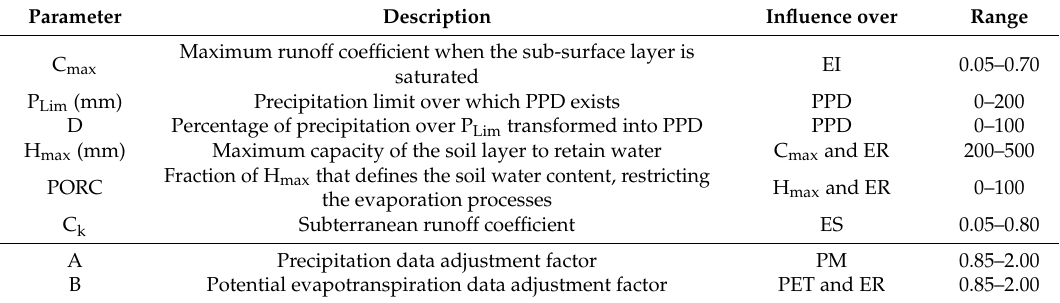
Table 1. Description of the model parameters, adjustment factors, and conceptual-physical range for the precipitation-runoff